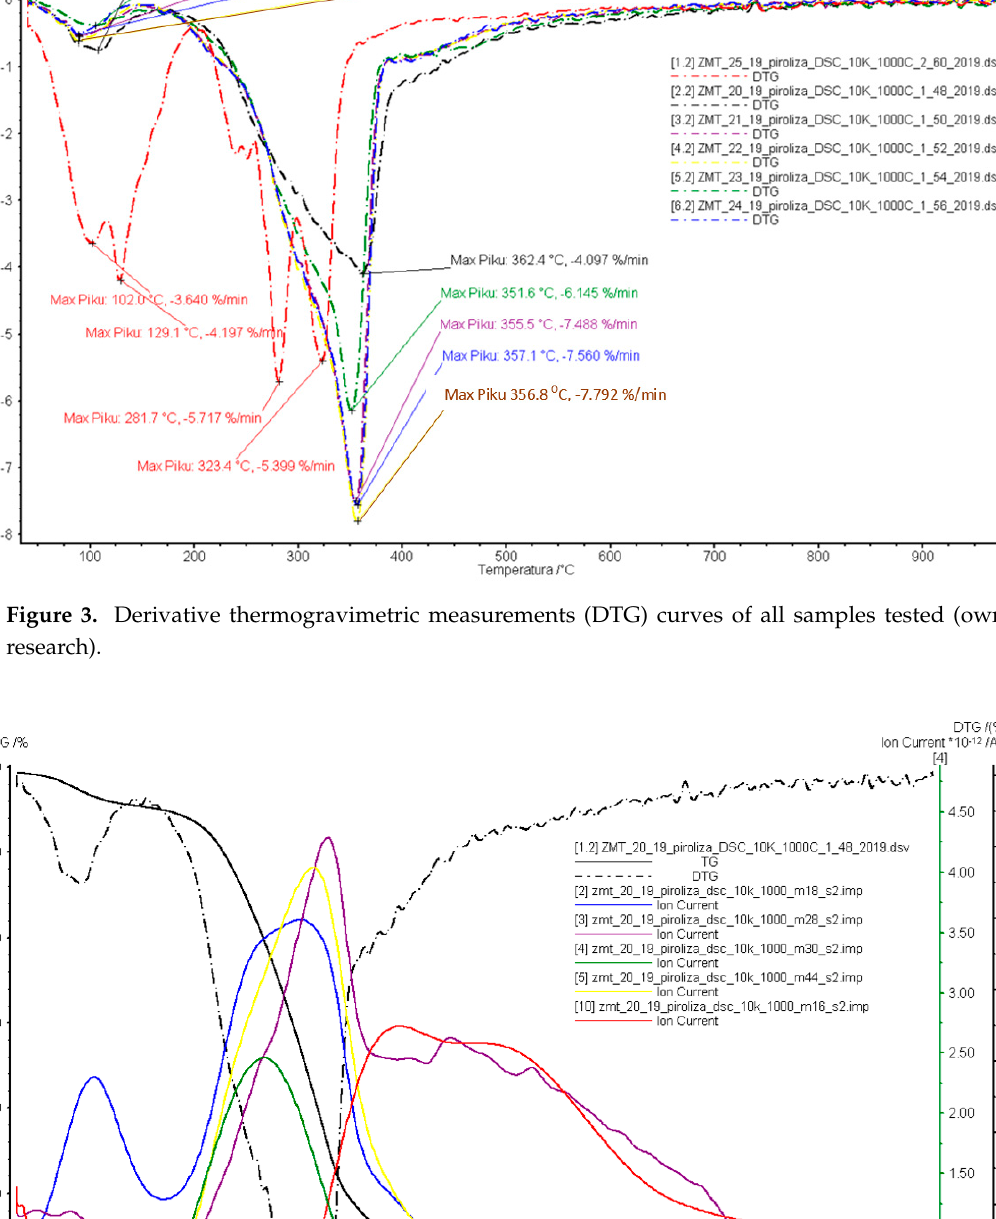
Figure 5. TG and DTG curves, and ion current intensity for the sample ZMT/24/2019 (own research).